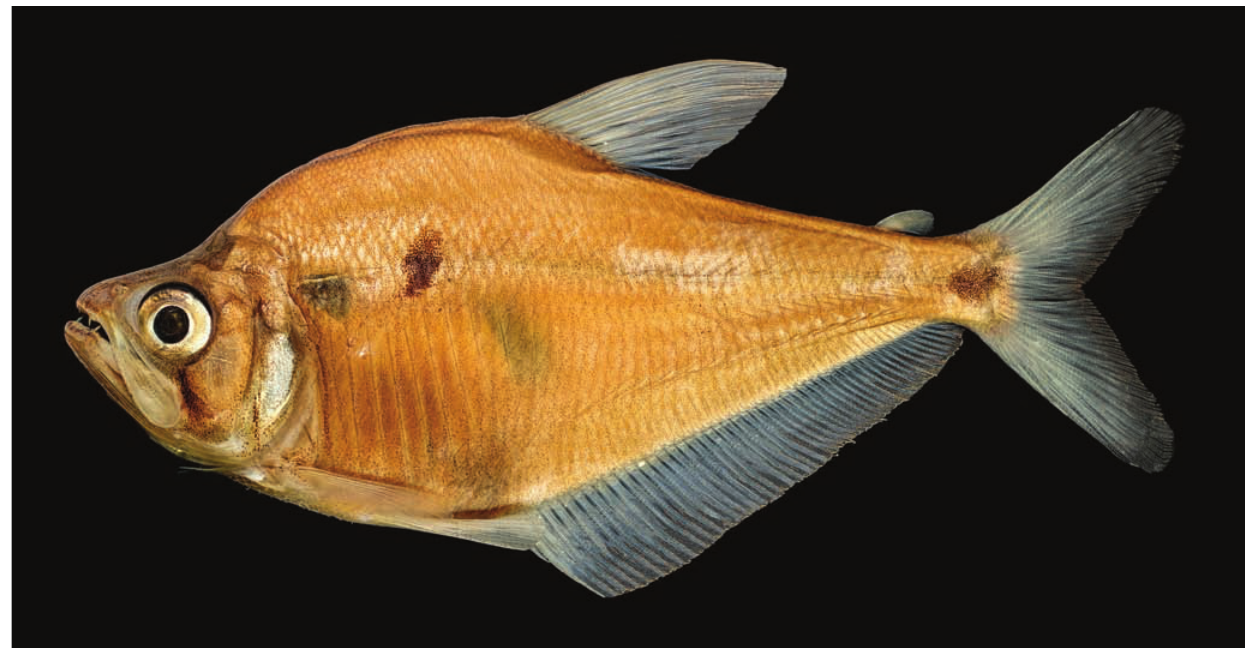
Fig. 22. Charax pauciradiatus MZUSP 19538, female, 100 mm SL, Brazil, Pará, rio Apeú, Boa